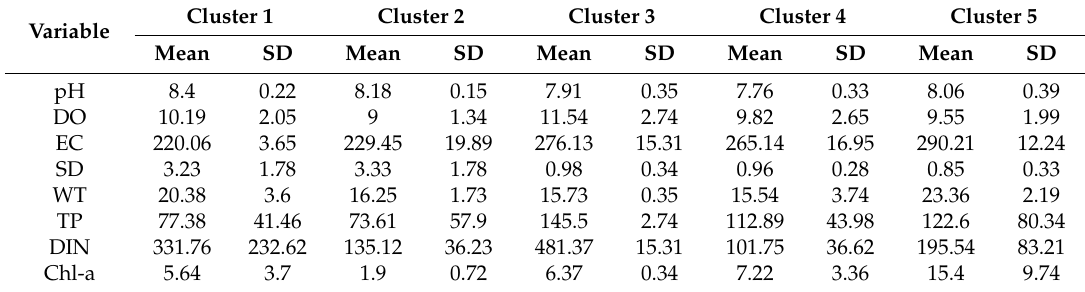
Table 3. Statistical description of the SOM’s clusters found using the K-means algorithm method, based on mean values and standard deviation (SD).